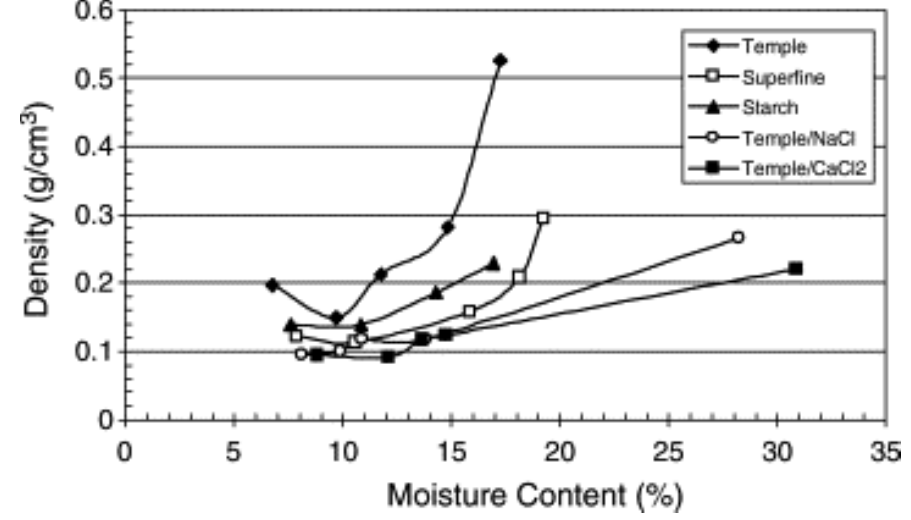
Figure 8. The densities of pellets microwave-foamed at different moisture contents. Reprinted with permission from the authors of [48]. Copyright © (2006) Elsevier.